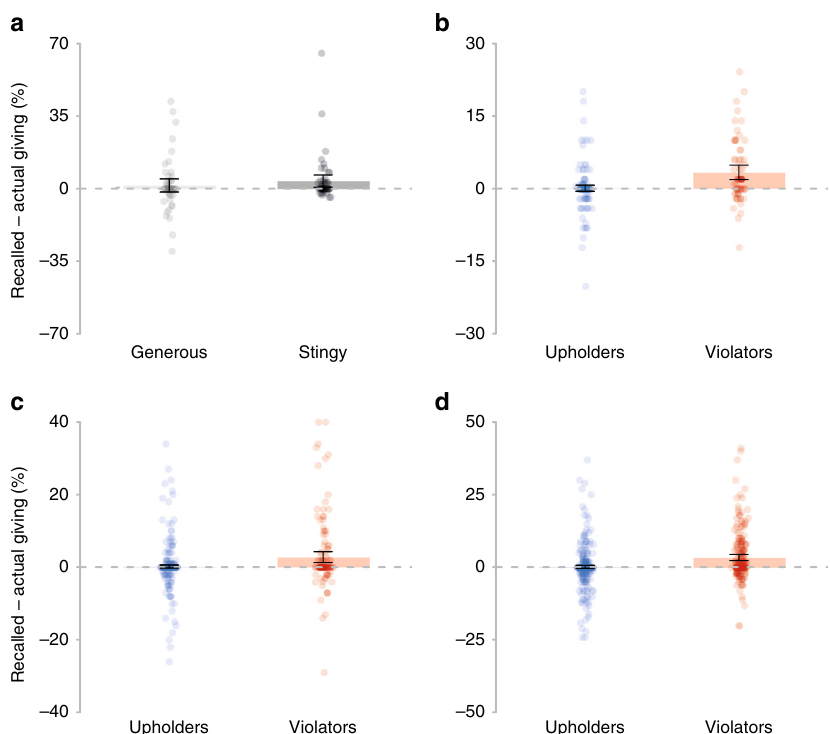
Fig. 1 Self-serving memory errors. Differences between the mean percent participants recalled giving, versus how much they actually gave. Positive values re fl ect “ self-serving ” memory errors. a In Experiment 1, relatively stingy-behaving participants recalled being more generous than they actually were, but not generous-behaving participants. b In Experiment 2, we show that speci fi cally individuals who violate their own personal standard of fairness (violators) recall being more generous than they actually were, but not those upholding their own fairness standard (upholders). In Experiment 3 ( c ) and